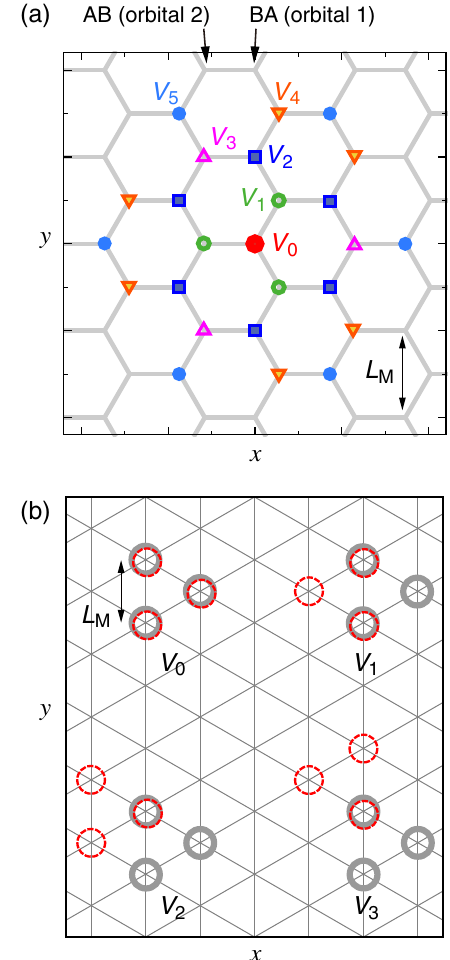
FIG. 6. (a) Labeling of the direct Coulomb interaction at different distances. Note that V 0 ; V 1 ; V 2 … represent the potential amplitudes between the origin and the indicated lattice points. (b) Overlapping of two Wannier orbitals in the configuration V 0 , V 1 , V 2 , V 3 . The three circles of the same line type represent the three peaks of a single Wannier state (Fig. 3).